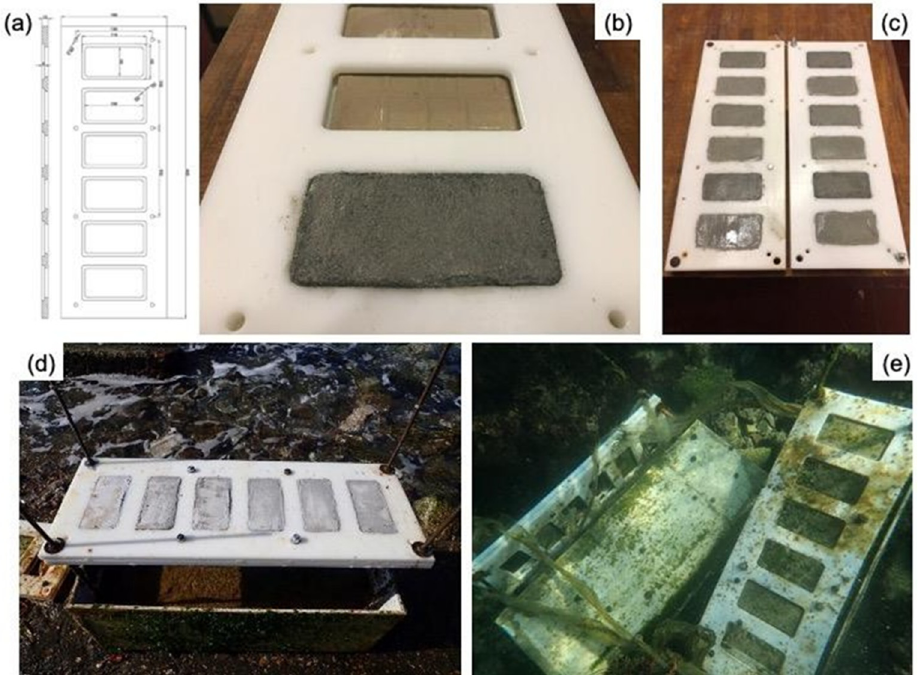
Figure 2. ( a – c ) Ertacetal holder plates with six (6) rectangular compartments for housing the mortar specimens (10 × 5 × 0.8 cm) and maintaining them fixed into the open sea bottom; ( d ) concrete anchors with the Ertacetal holders positioned before immersion; ( e ) view of the holders into the sea bottom.